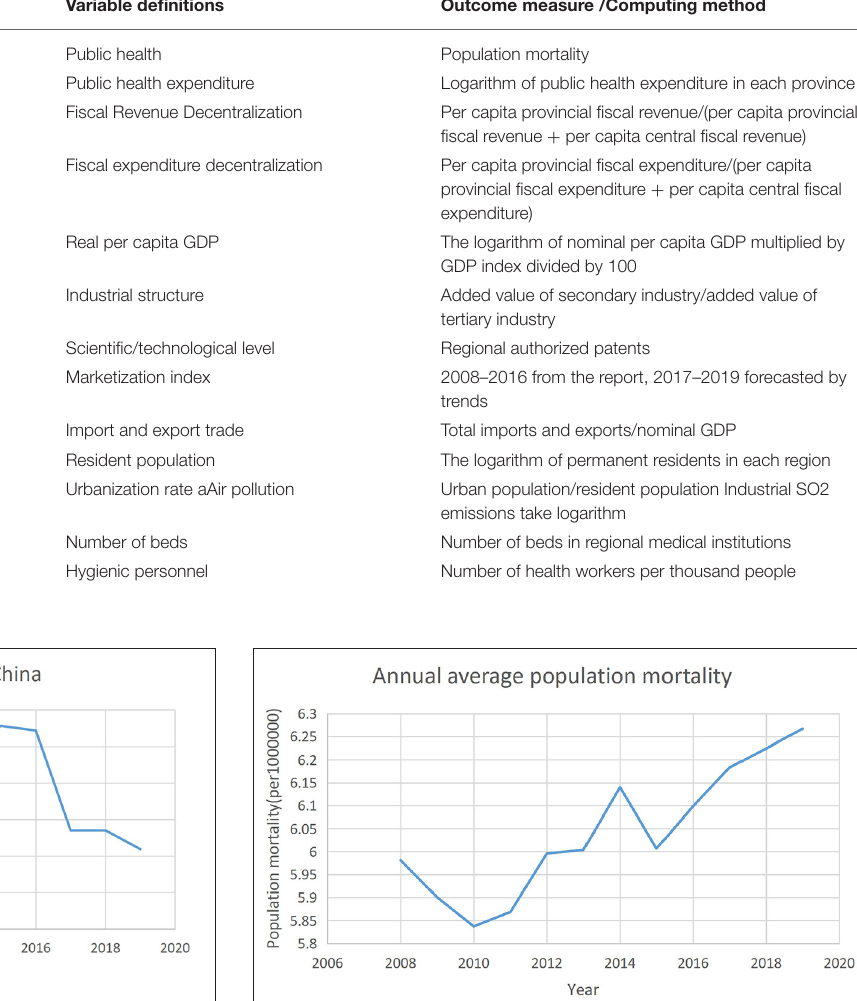
FIGURE 2 | Annual average population mortality in China in the period of